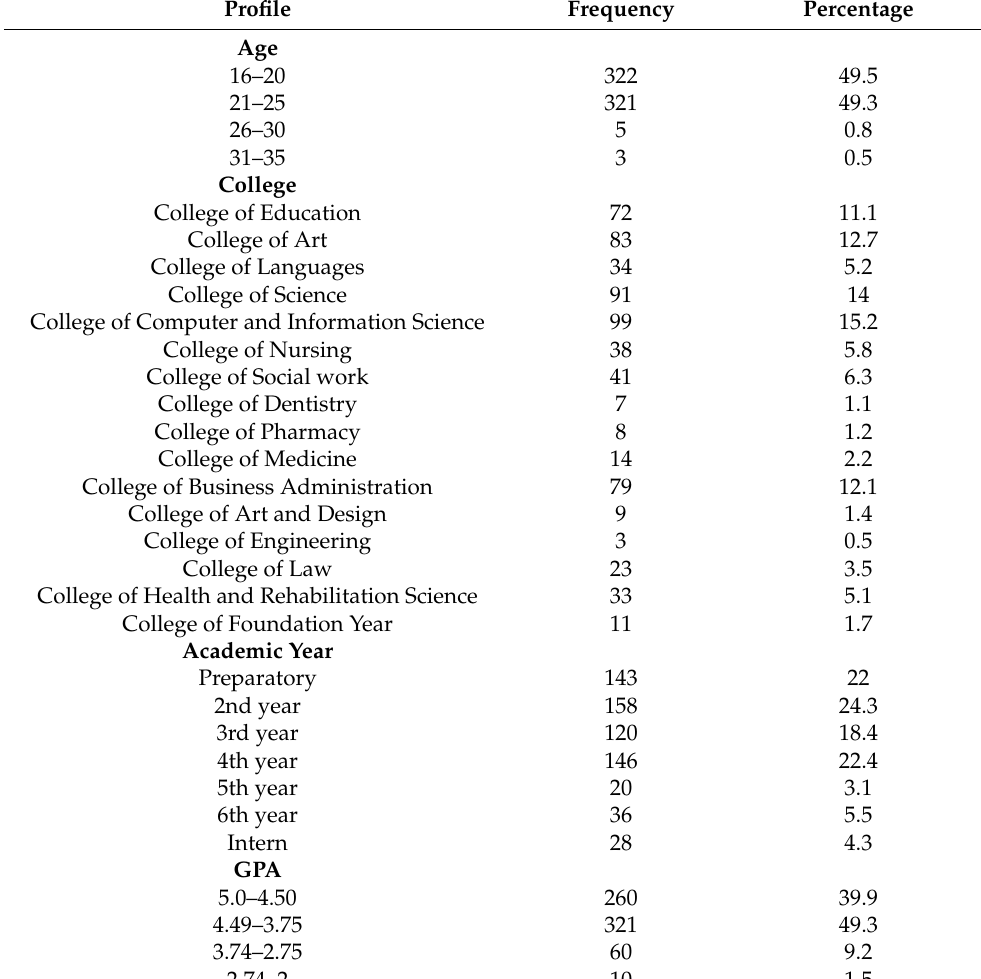
Table 1. Demographic